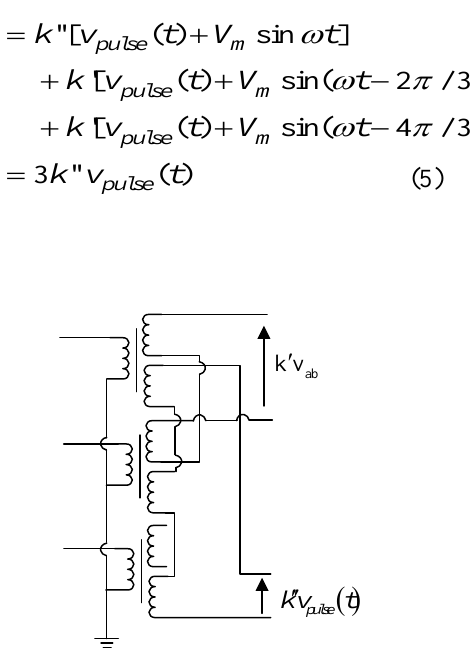
Figure 4: Separation transformer.